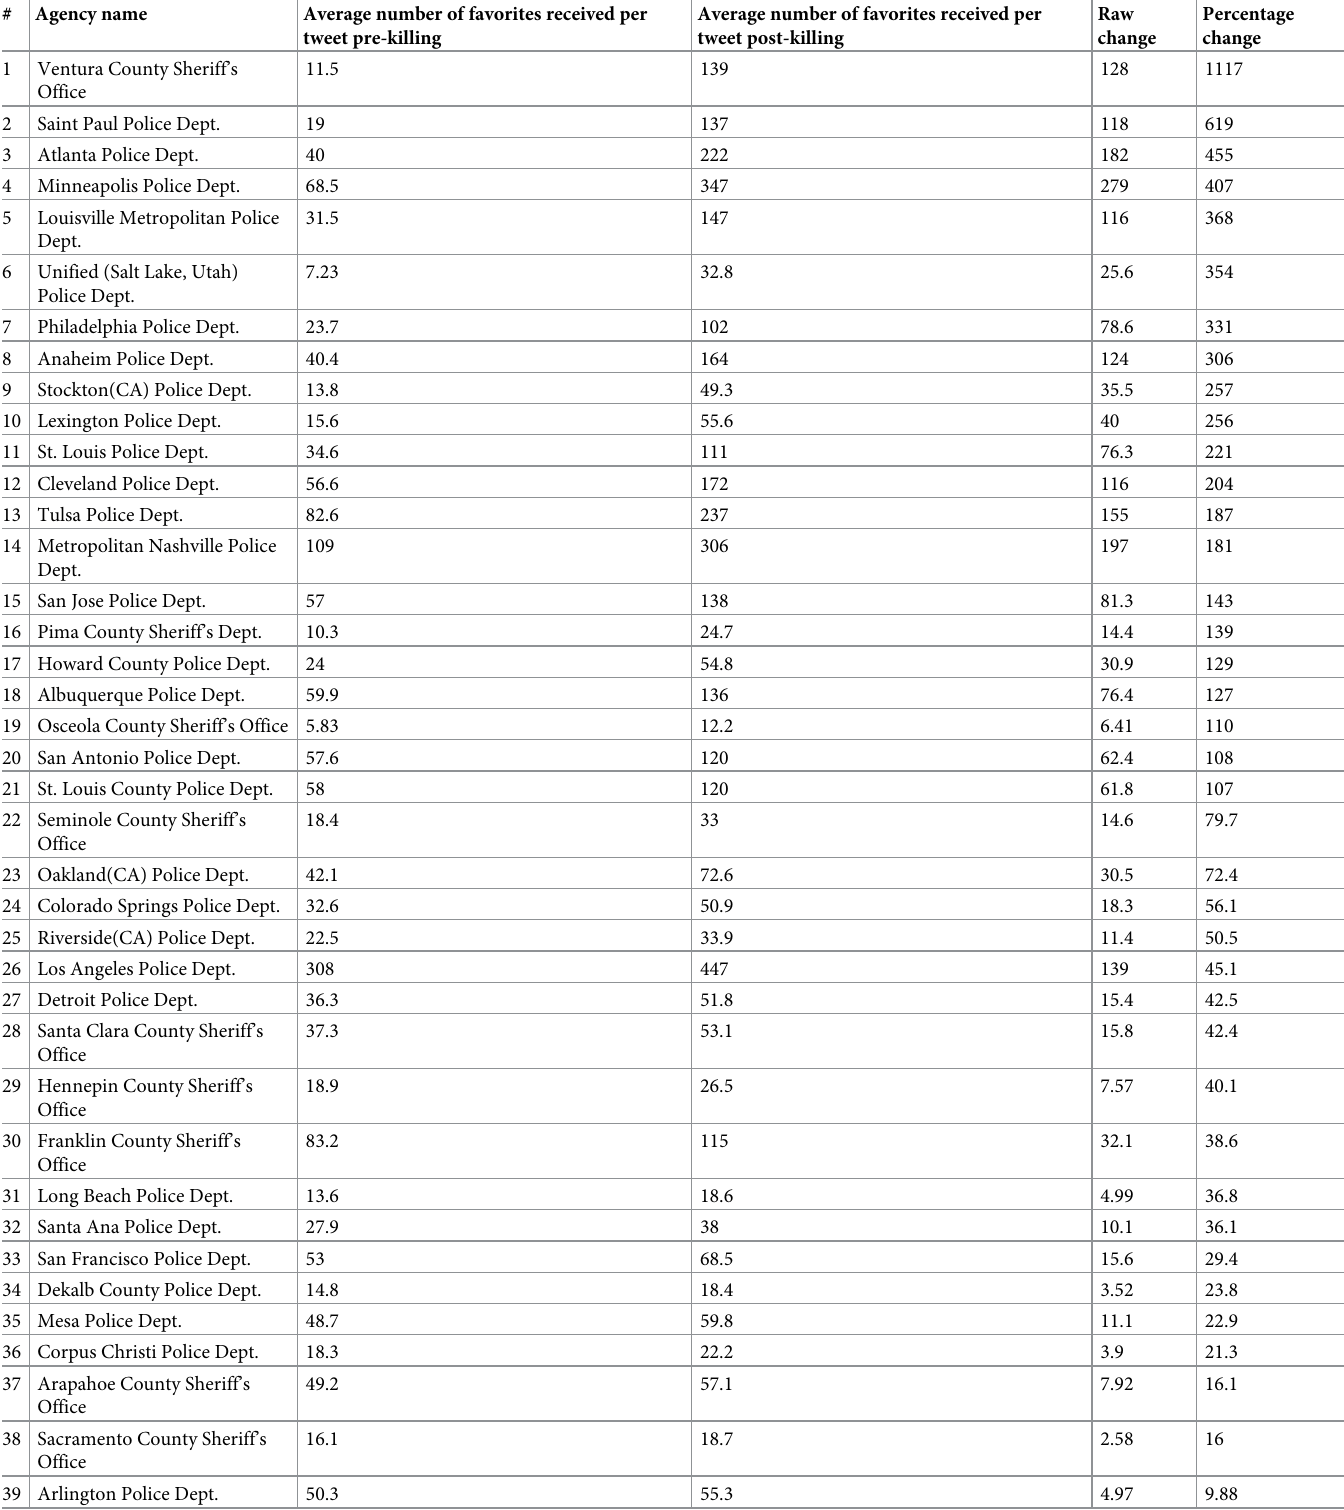
Table 6. Agencies (in the lower-use group) ranked by the increase in the received favorites per tweet before and after the